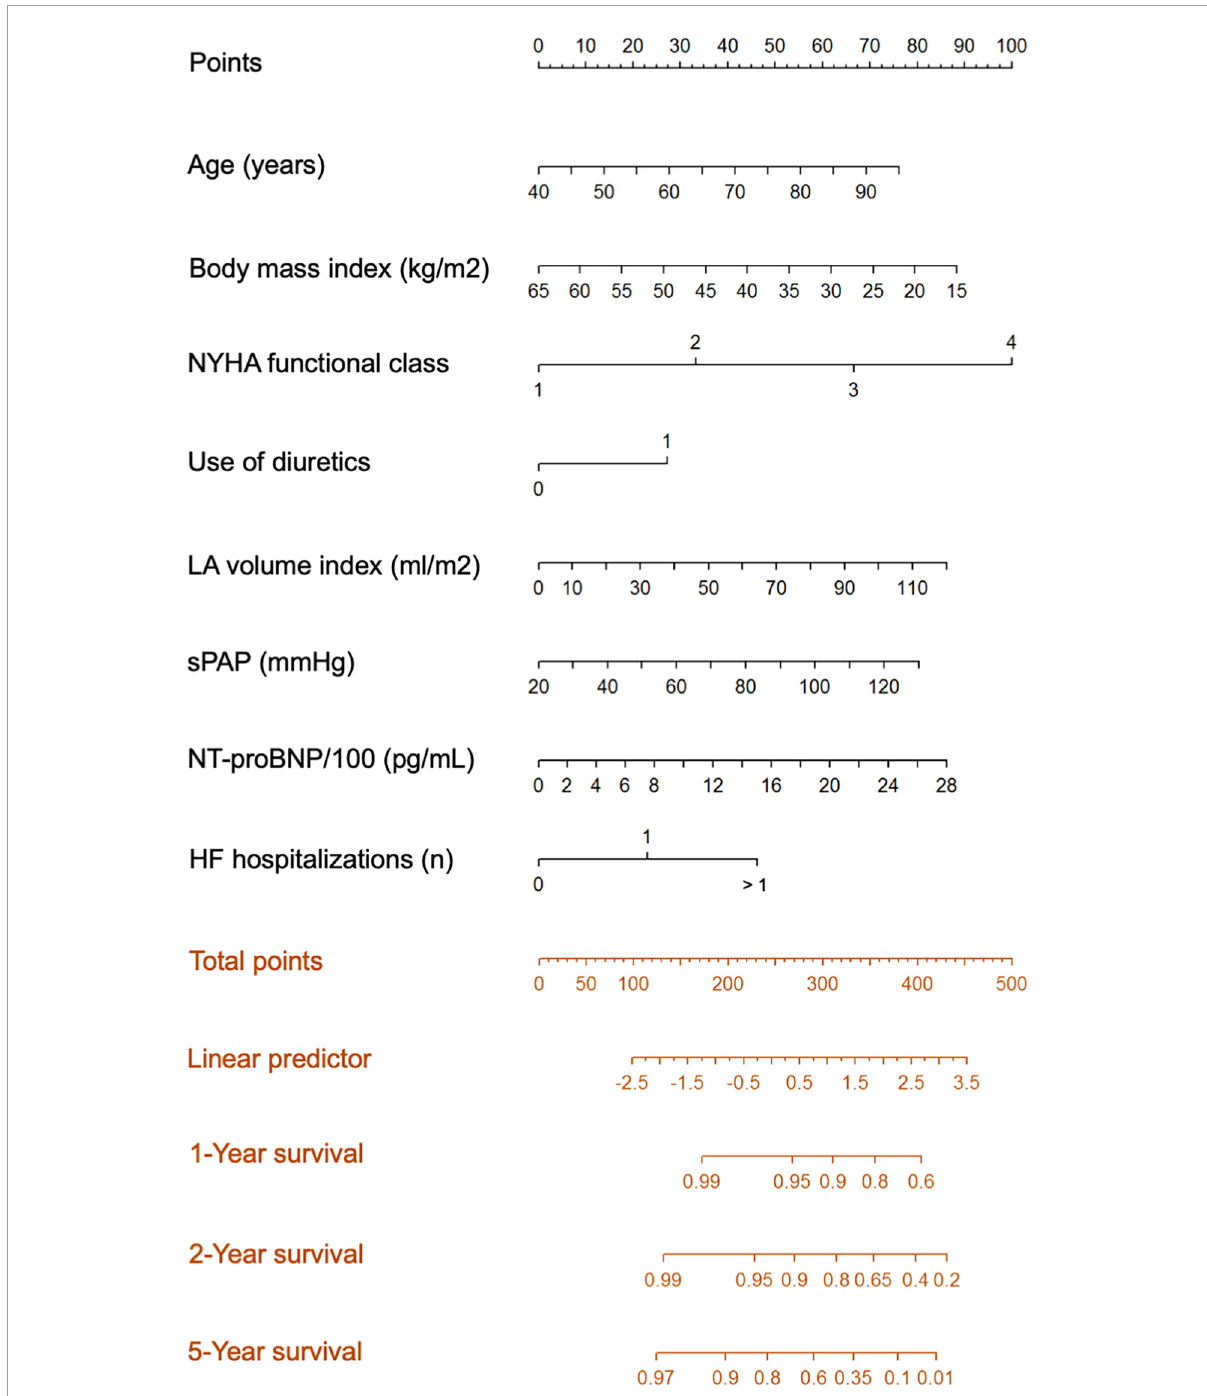
FIGURE3 The Hfpef survivAL hOspitalization (HALO) prediction model for all-cause mortality.